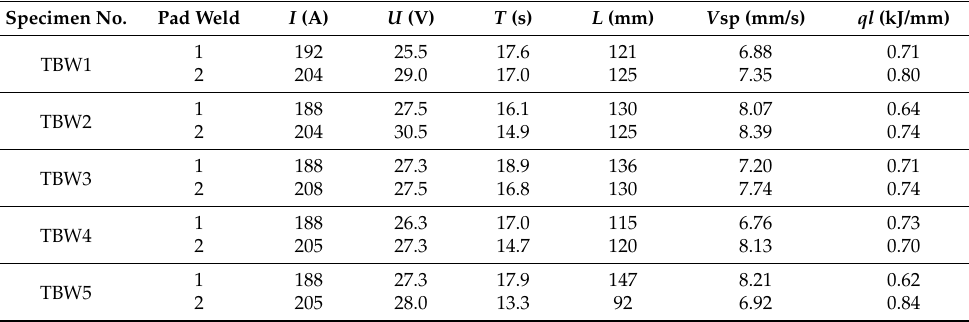
Table 4. Welding parameters for the TBW technique.